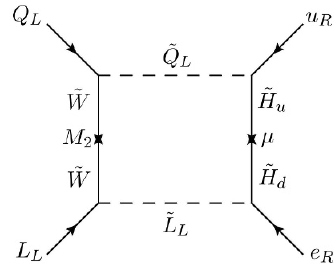
Figure 3 . Feynman diagram of the MSSM contribution to